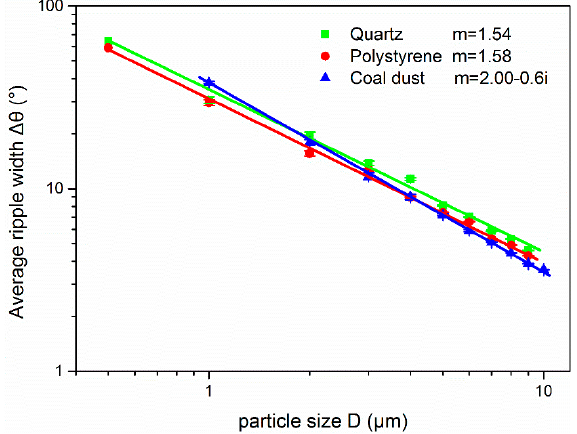
Figure 5. Comparison of the fitting curves between ripple width and particle size for particles with different refractive indexes.